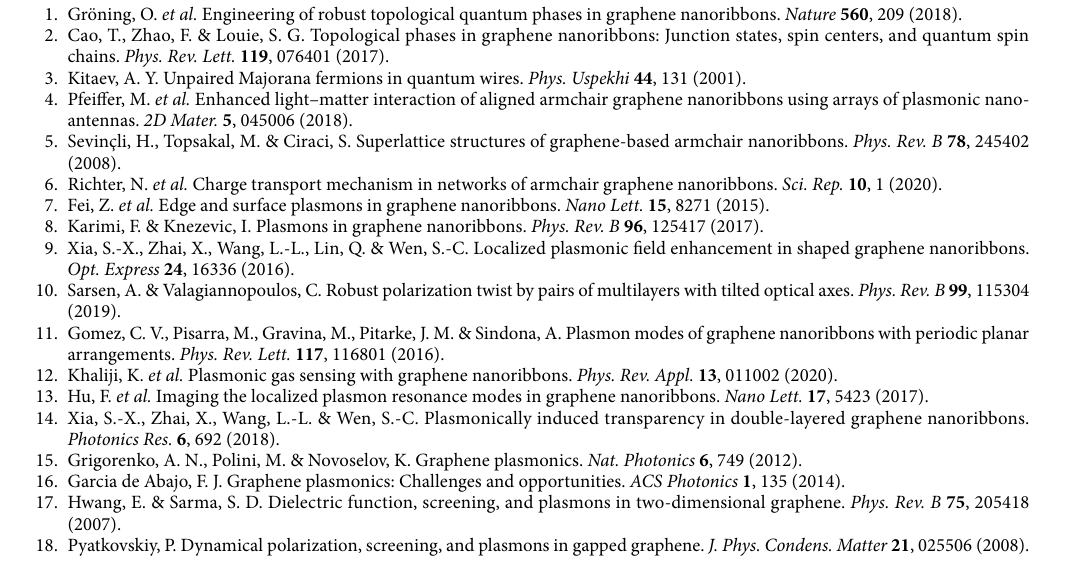
Figure 7. Panel ( a ) presents plasmons for different electron densities, correspond to E F / E ( 0 ) 2.0 (red) in a narrow ribbon of N R (red) in a wide nanoribbon of N R in a narrow metallic electron-doped α spectrum in a wide metallic graphene nanoribbon. Other parameters are the same as those in Fig.